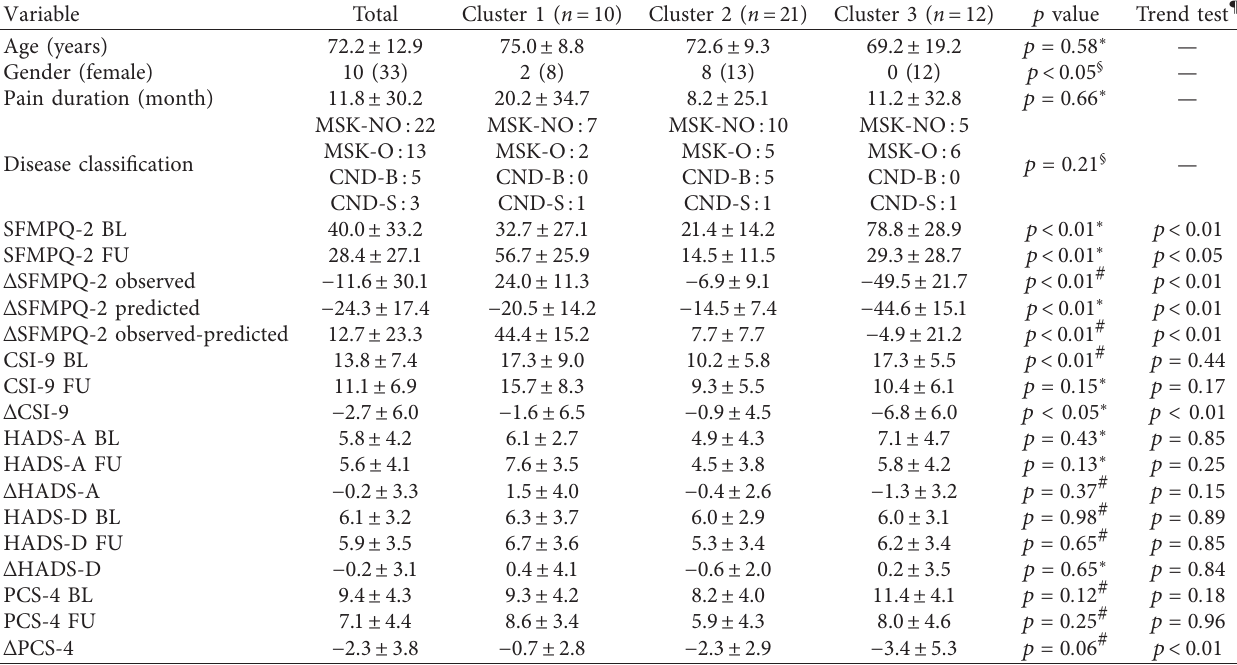
Table 1: Characteristics of each variable in each